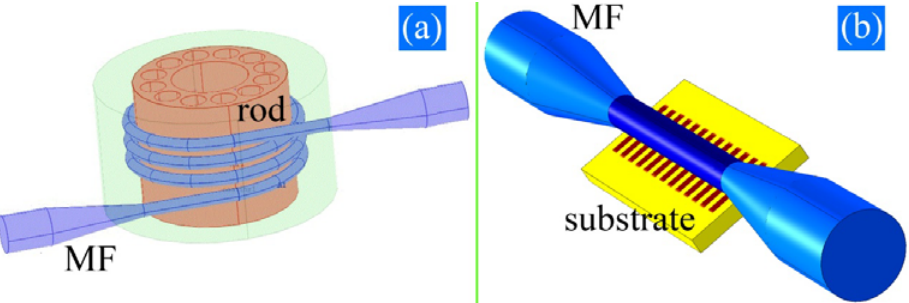
Figure 3. Proposed MFBGs by wrapping a MF on a microstructured rod with an internal channel [41,44] or by laying the MF on a substrate with pre-treated microstructures